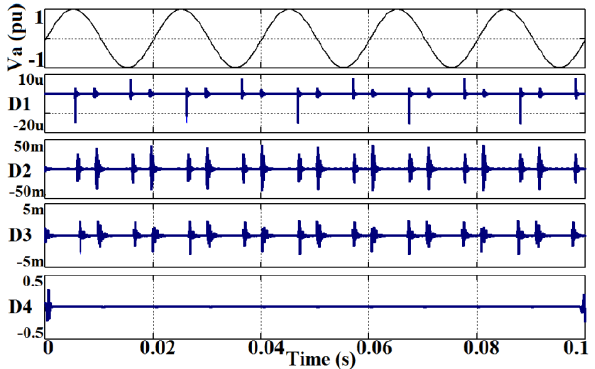
Figure 10. DWT details for saturation Transformer.